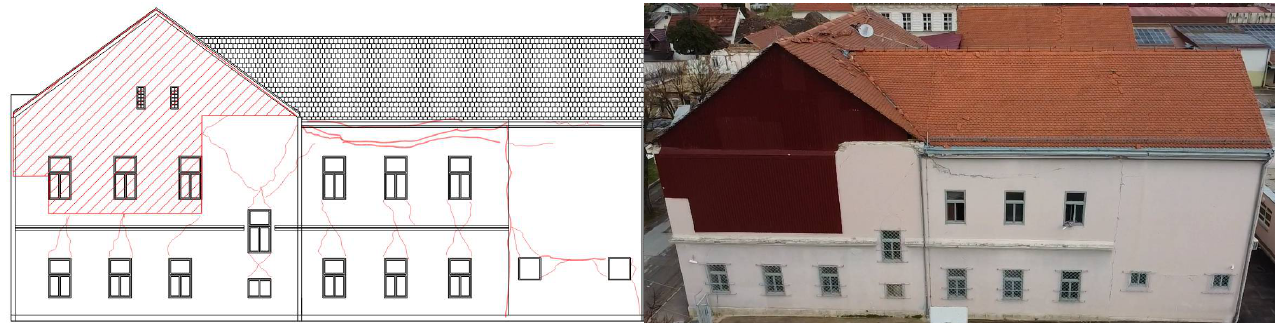
Figure 10. Southeastern façade plan with marked damage.